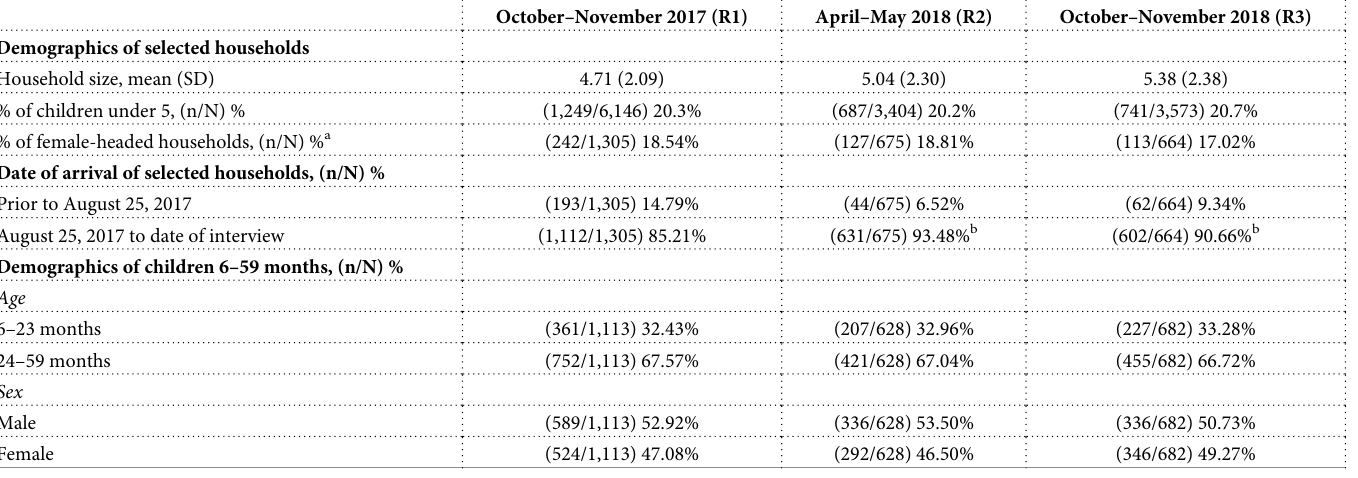
Table 1. Demographic profile of sampled households and children—Bangladesh,